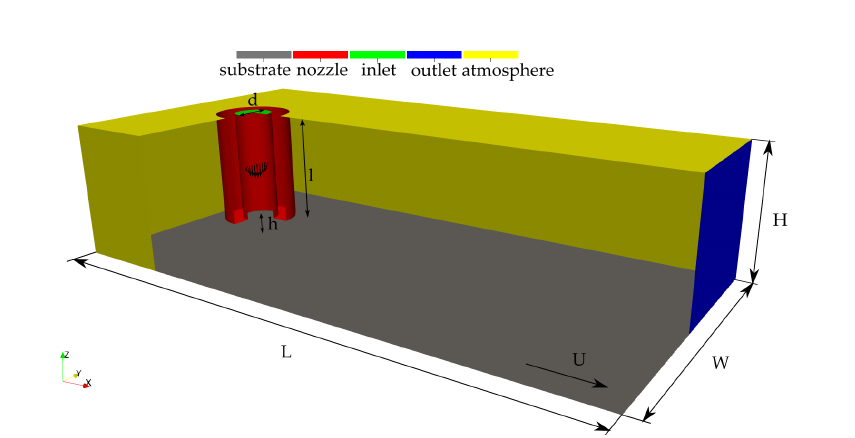
Figure 7. Computational domain and boundary conditions.